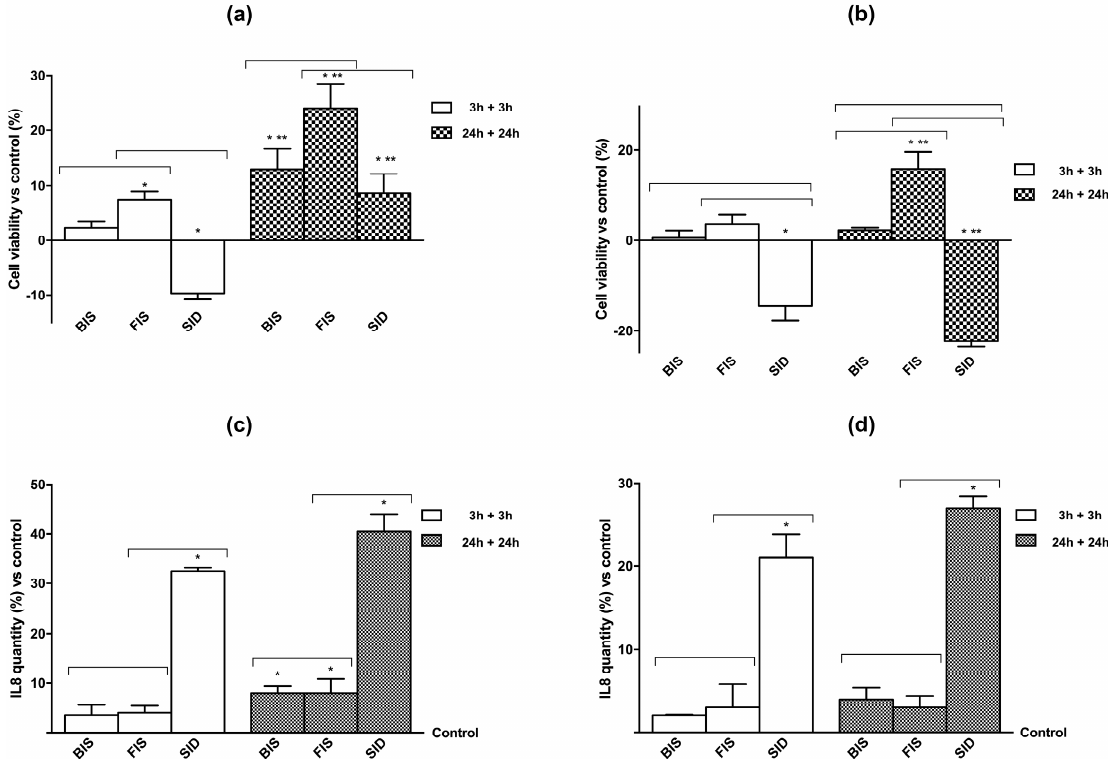
Figure 6. Cell viability and IL-8 concentration measured on GTL-16 and Caco-2 cells maintained for equal time (3 h plus 3 h; 24 h plus 24 h) without iron treatments. In ( a ) and ( b ) cell viability, measured by MTT assay, and in ( c ) and ( d ) IL-8 concentration, measured by ELISA kit, on both cell types are reported. Data are expressed as means ± SD (% vs. control) of four independent experiments for each cell type. * p < 0.05 vs. control; ** p < 0.05 vs. correspondent column at different time; bars p < 0.05 among different treatments at the same time.